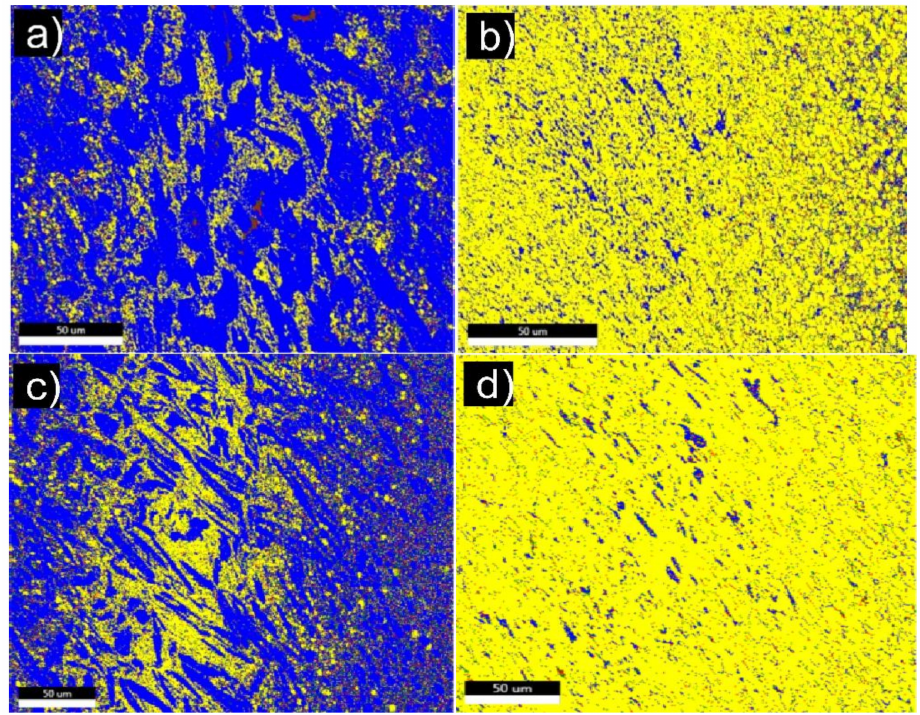
Figure 6. EBSDmicrographcomparisonofcomposites: ( a )Ti+10wt%(Ti,Mo)C;( b )Ti+10wt%(Ti,Mo)C/C; ( c ) Ti + 20 wt %(Ti,Mo)C; ( d ) Ti + 20 wt %(Ti,Mo)C/C. SEM and TEM micrographs of the microstructure of the Ti + (Ti,Mo)C and Ti +